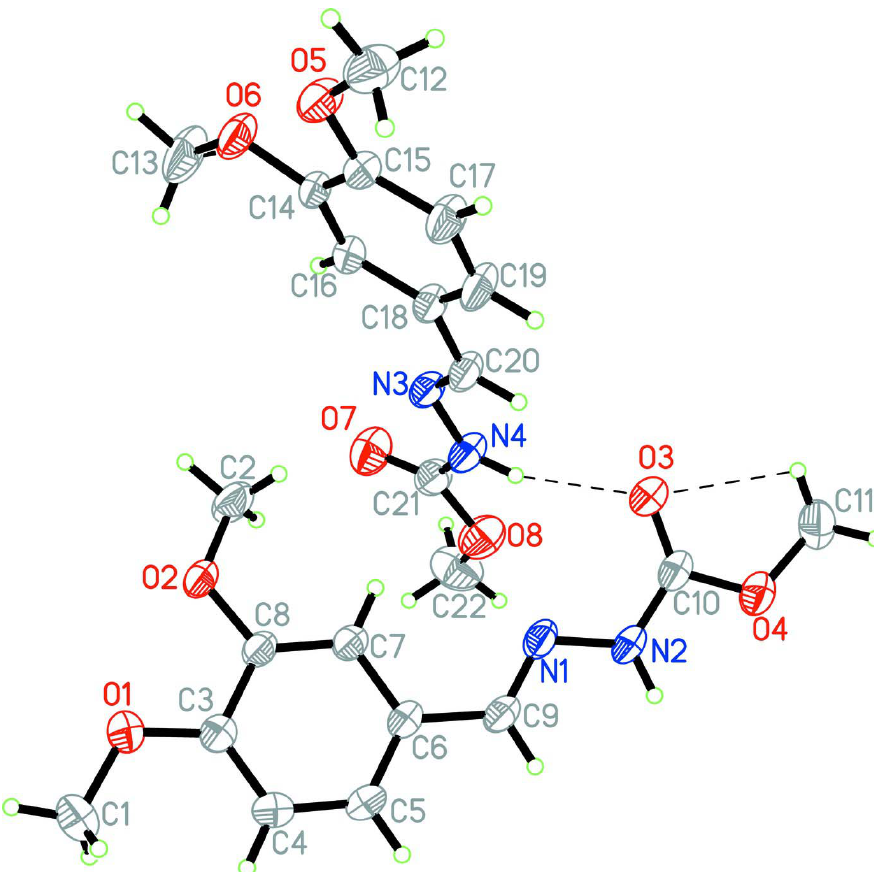
Figure 1 Molecular structure of (I), showing 20% probability displacement ellipsoids and the atomic